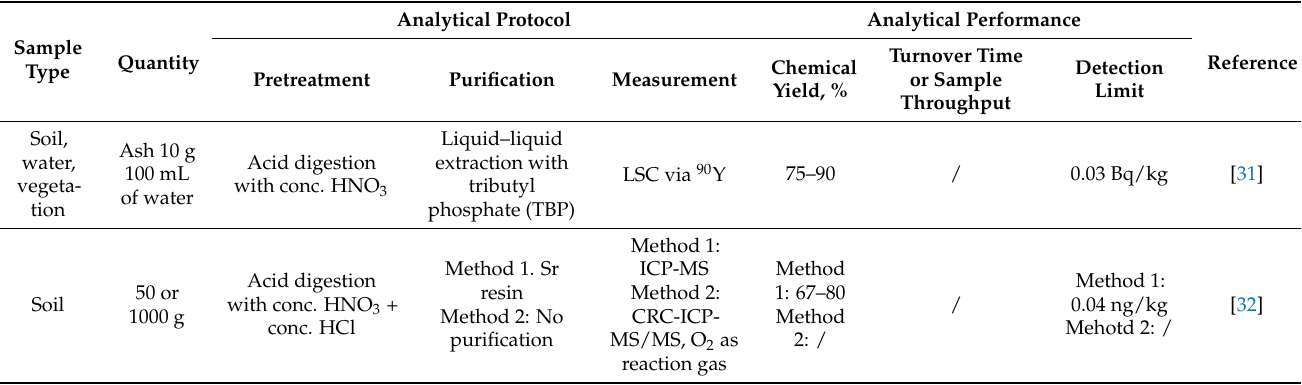
Table 1. Overview of analytical methods developed for determining 90 Sr in environmental and biological samples since